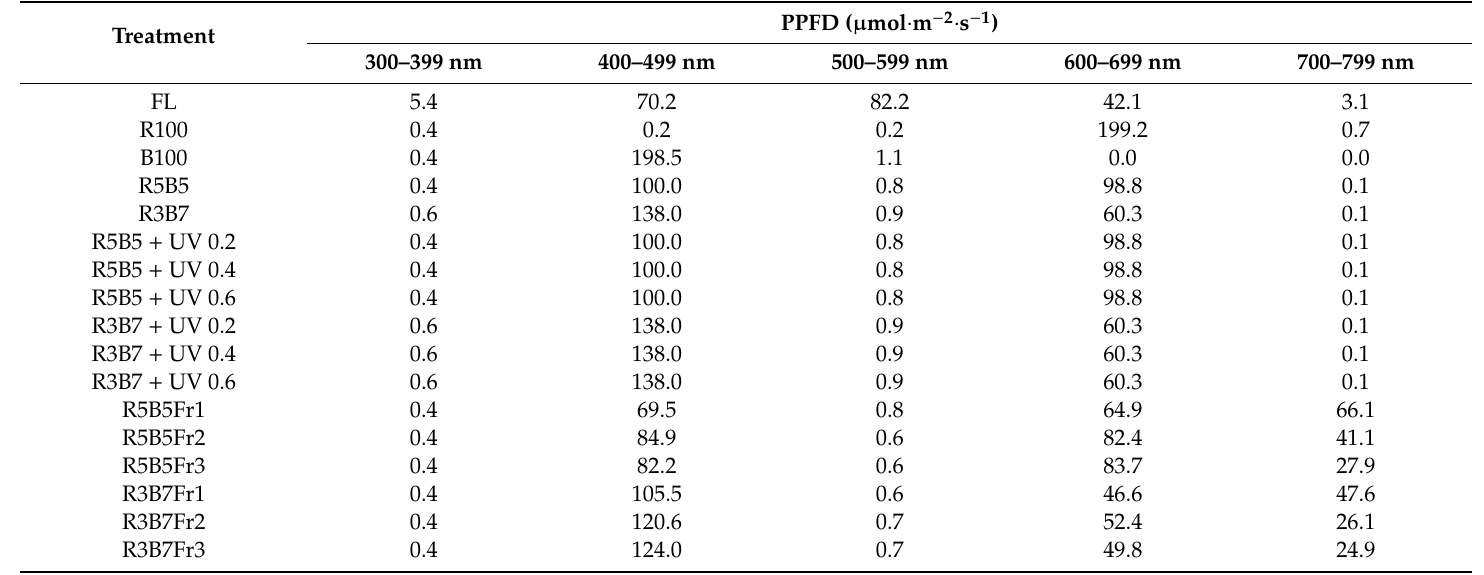
Table 2. The light intensity of each wavelength in di ff erent light quality combinations.